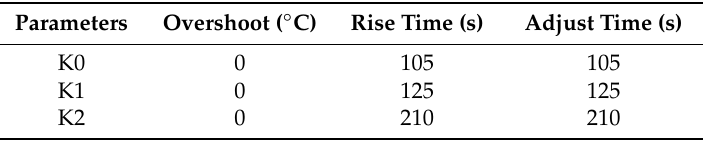
Table 14. Comparison of parameters of regulator adjustment.